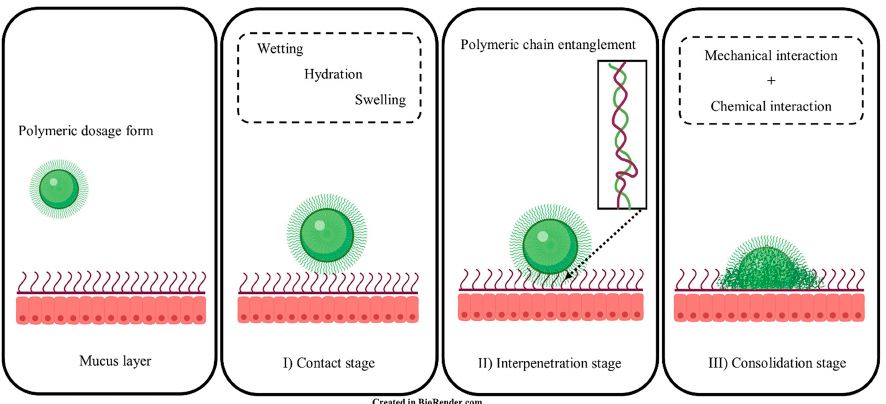
Figure 2. Illustration of mucoadhesive interaction(s) between polymers and mucin glycoproteins. I) Contact stage, II) Interpenetration stage and III) Consolidation stage. Adapted from Ahmady et al.